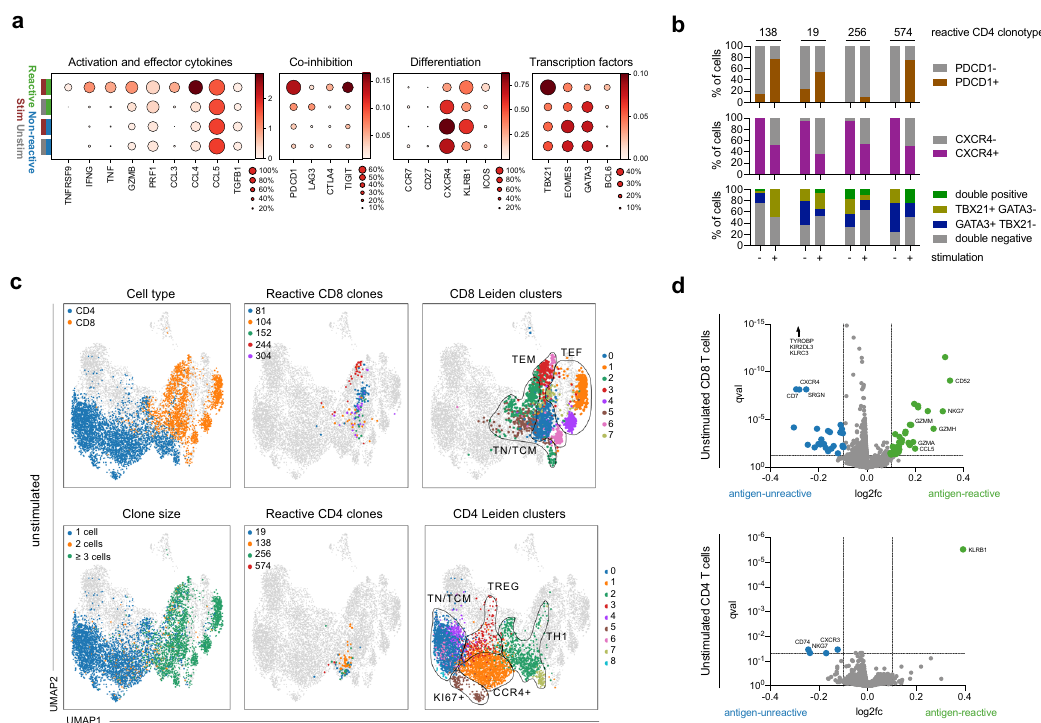
Fig. 3 Reverse phenotyping reveals systematic biases induced by antigenic stimulation and allows precise de fi nition of ex vivo transcriptional pro fi les of SARS-CoV-2 antigen-reactive T cells. a Dot plots of log-normalized expression of selected marker genes by clonotype group (reactive and non- reactive) and by condition (stimulated: “ stim ” , unstimulated: “ unstim ” ) for CD4 T cells (stimulated reactive n = 68, unstimulated reactive n = 178, unstimulated nonreactive n = 539, stimulated nonreactive n = 249). b Fraction of gene-positive cells with >0 UMIs on the presented gene by clonotype and condition ( + : stimulated, − : unstimulated). c UMAPs indicating cells from the unstimulated condition in colors with cells from the stimulated condition shown in gray ( n = 11,460 cells in total); CD4 or CD8 T cell state (top left panel), clonotype size as de fi ned through cell number (bottom left panel); reactive CD8 clonotypes as de fi ned in ( a ) (top middle panel) or reactive CD4 clonotypes as de fi ned in ( b ) (bottom middle panel), with all other cells not belonging to that clonotype also shown in gray; CD8 (top right panel) and CD4 (bottom right panel) Leiden clusters, including manual annotation of cluster groups for the sake of clarity. d Volcano plots of differential expression test of cells from non-reactive versus reactive clonotypes in unstimulated CD8 (top) and CD4 (bottom) T cells. For the sake of clarity, TYROBP (l2fc − 0.48; qval 7 × 10 − 131 ), KIR2DL3 (l2fc − 0.15; qval 3 × 10 − 60 ), and KLRC3 (l2fc − 0.13; qval 3 × 10 − 55 ) are not displayed (CD8). Data are shown for patient